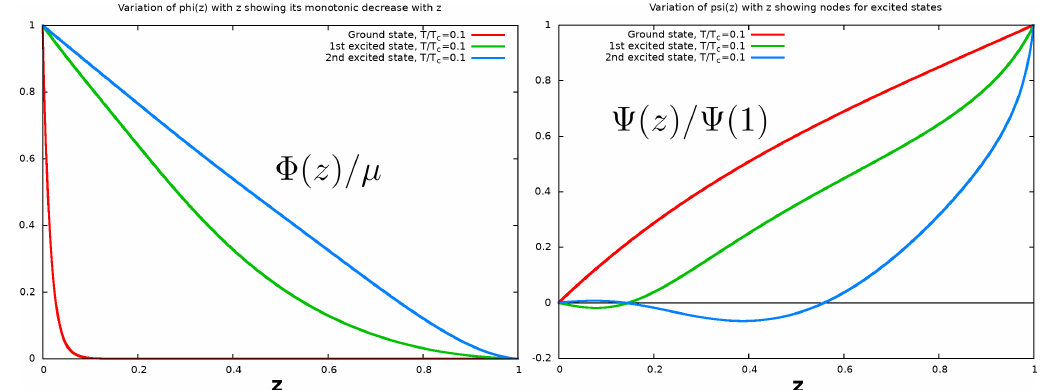
Figure 1 . Numerical solutions of equations of motion for hO 1 i condensate at µ = 8 , L = 1 , k = 1 , and at temperature T/T c = 0 . 1 for the field Φ( z ) (left) and Ψ( z ) (right) as functions of z . There are three different condensate solutions with this set of parameters: ground state solution (red), first excited state solution (green), second excited state solution